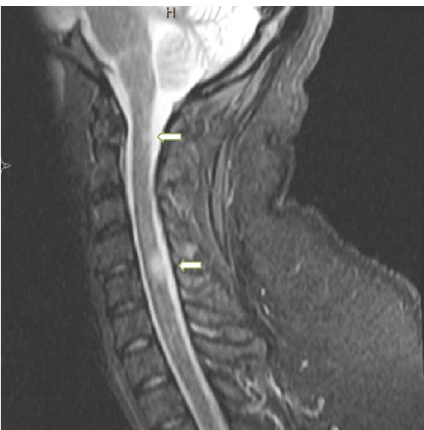
Figure 1: Sagittal T2-weighted images of the cervical spine showing abnormal signal cord at C2 and C4-5 level (arrows).